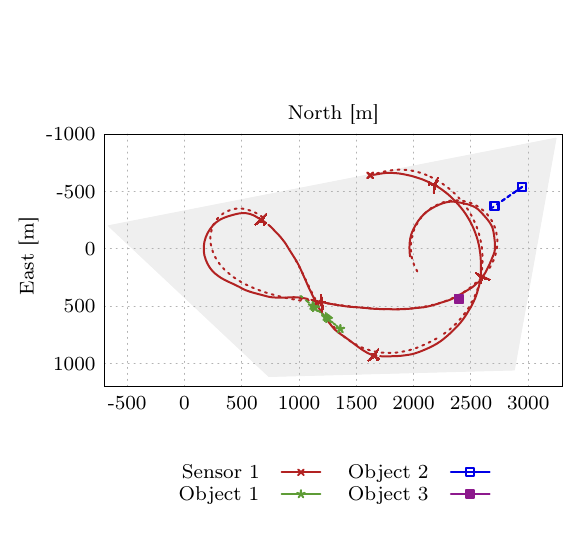
Figure 10: The mobile sensor performs remote sensing of the three objects in question. The dashed line represents optimized/predicted trajec- tories, whereas solid lines are filtered val- ues. Every aircraft marker represents the instant when a new sampling interval is uti- lized. An object observation is represented with a line marker. The shaded polygon is the admissible region.